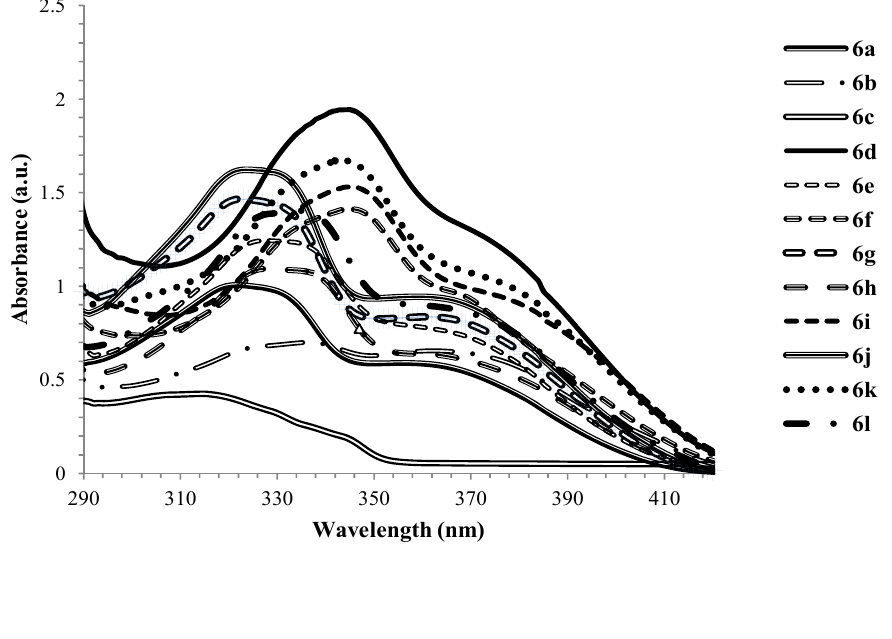
(2.0 × 10 − 5 mol/L). 3